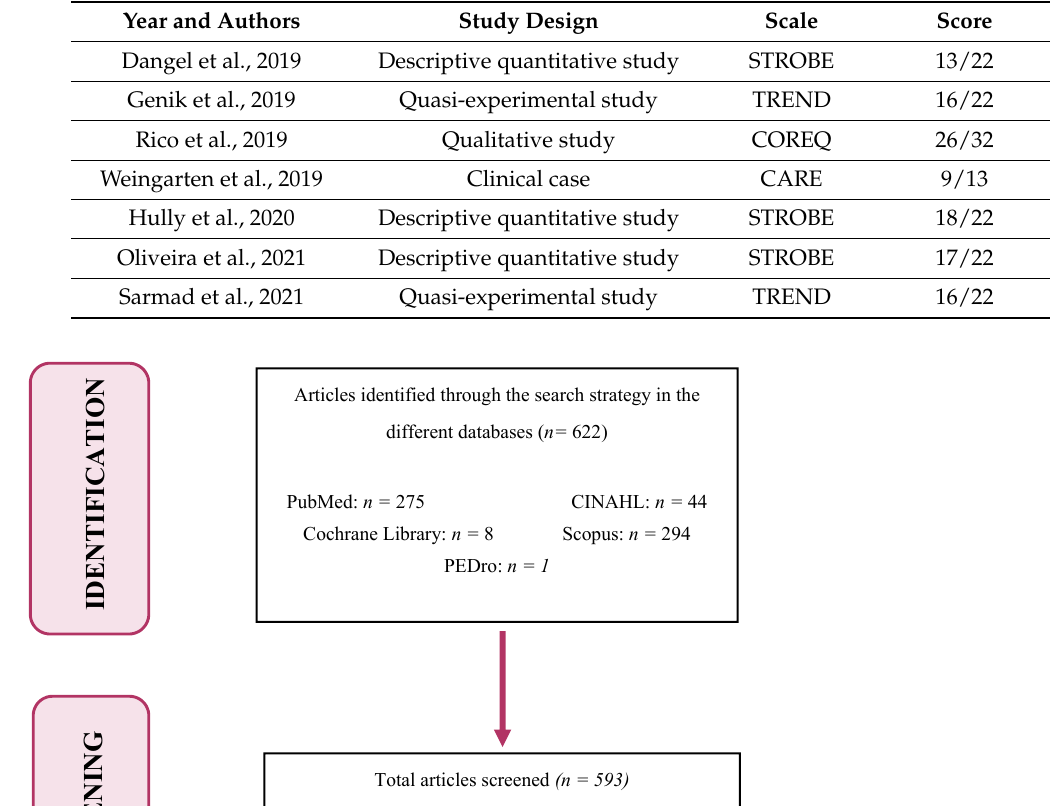
Table 3. Evaluation of the methodological quality with STROBE for the descriptive quantitative studies, CARE for the clinical cases, TREND for the quasi-experimental studies, and COREQ for the qualitative studies.